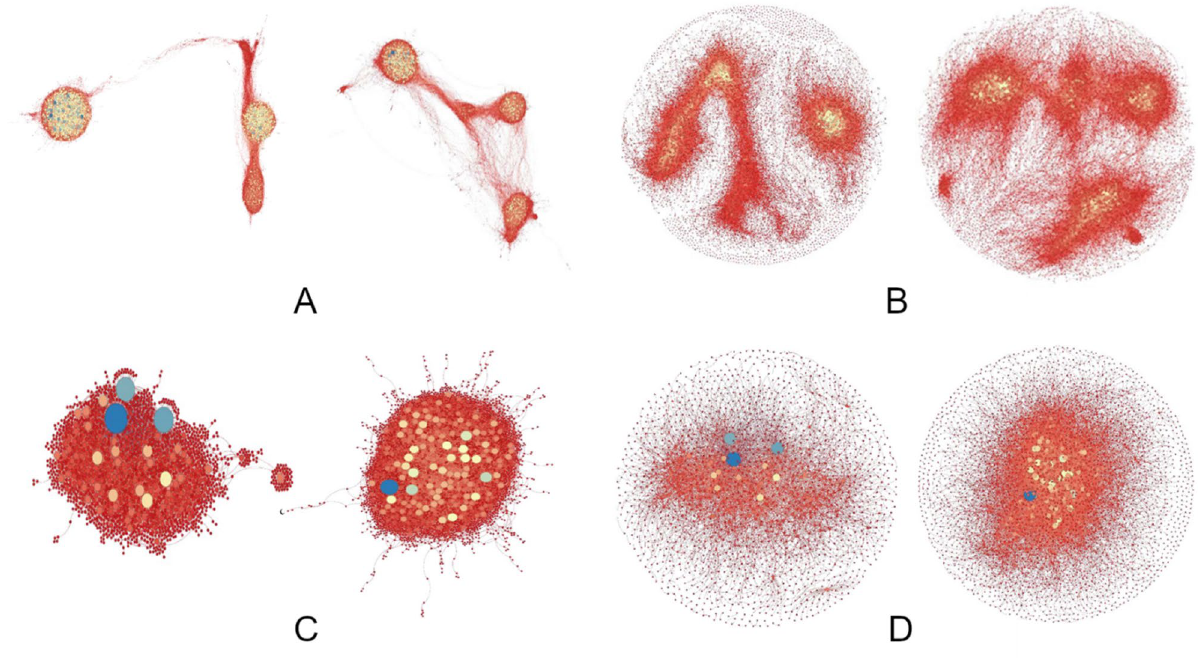
Figure 5. High-correlation specific networks with non-shared-nodes, ForceAtlas2 ( a , c ) and Frutcherman- Reingold ( b , d ) algorithms. For each figure, the network on the left shows the high correlation network specific to parous, while the network on the right shows the network specific to nulliparous. These are networks specific to a group, coherent with changes in the correlation structure after FFTP caused by variation in chromatin remodeling. (a, b) High positive correlation networks, 0.8 ≤ ρ < 1, ForceAtlas2 (a), Fruchterman-Reingold (b). (c, d) High negative correlation networks, -1 < ρ ≤ 0.8, ForceAtlas2 (c), Frutcherman-Reingold (d).